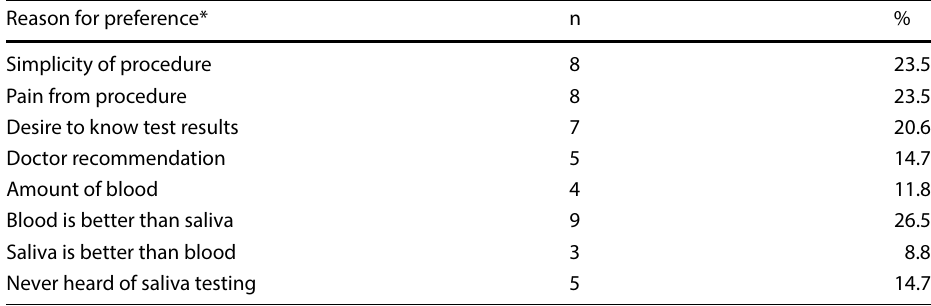
Table 4 Reasons caregivers preferred a specimen type (n =